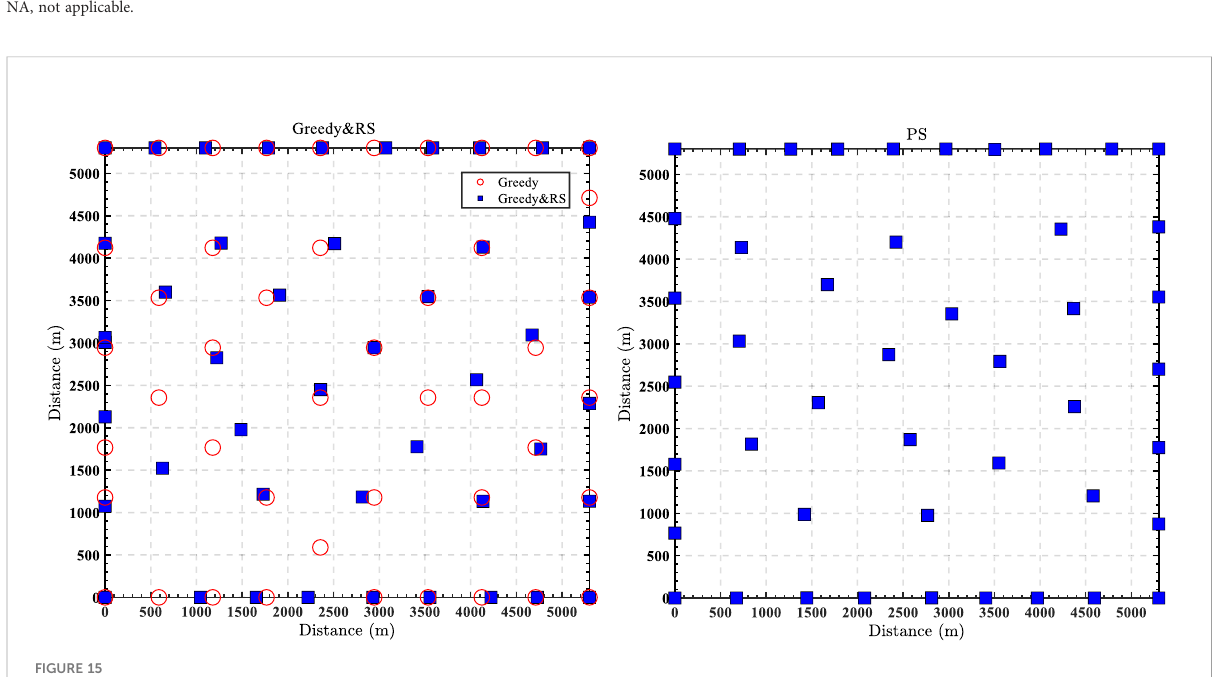
FIGURE 15 Comparison of optimization results of different algorithms for Case Maine.